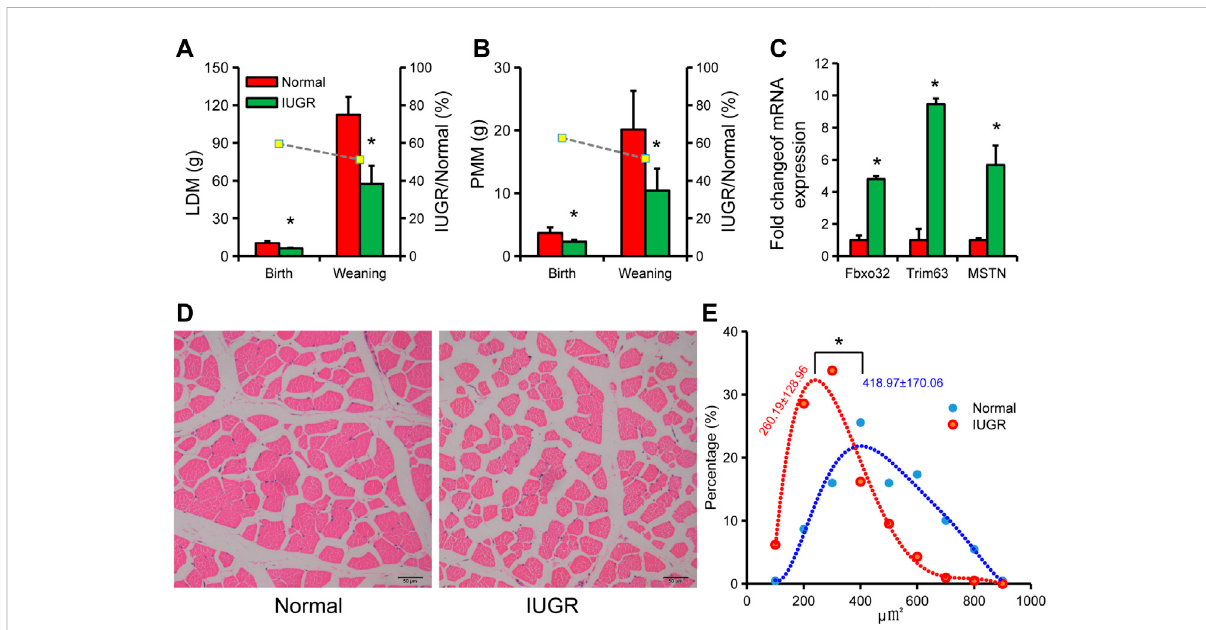
Characteristics of skeletal muscle tissue in intrauterine growth restriction (IUGR) and normal-size pigs. (A) Longissimus dorsi muscle (LDM) weight ofIUGRand normal-size pigs atbirth and weaning. (B) Psoas major muscle (PMM) weightof IUGR and normal-size pigs at birth and